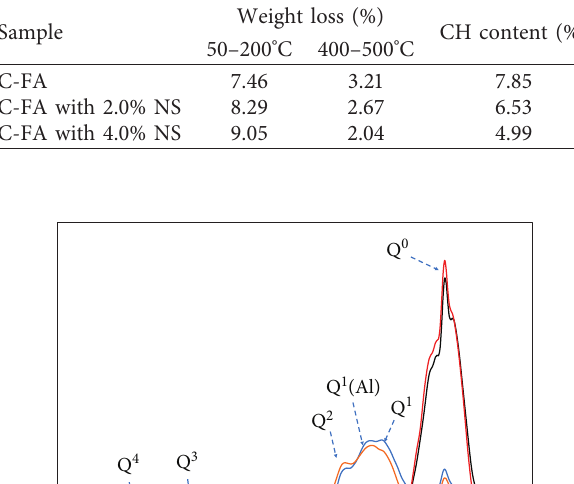
Figure 10: DTG analysis of paste hydrated for 28d.